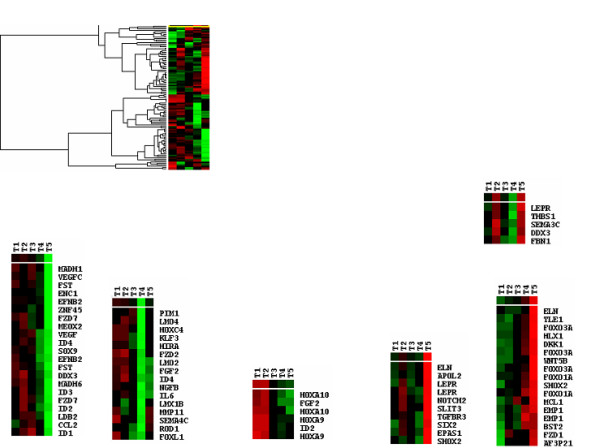
Functional classification of dexamethasone induced transcriptome. Hierarchical cluster analysis of developmental genes 106/1092 mRNA transcripts that encode developmental processes had a SLI of ≥ 5 and a SLR ≤ -0.4 and ≥ +0.4 in one or more timepoints compared to control (T1). This Figure shows both total cluster and specific coordinate regulation clusters of developmental genes significantly altered in at least one time point. T1 = control, T2 = 30 mins, T3 = 60 mins, T4 = 120 mins and T5 = 240 mins dexamethasone exposure